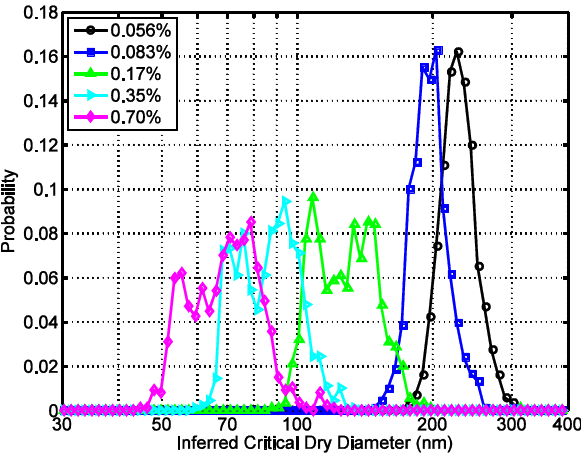
Fig. 5. Probability distribution of the inferred critical dry